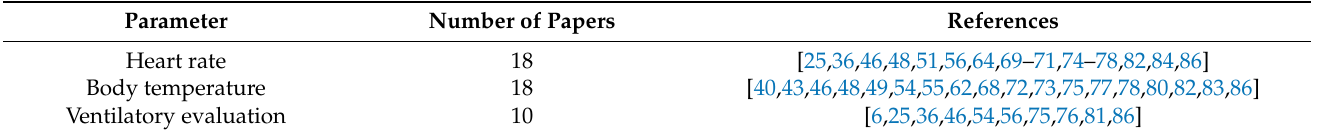
Table 2. Selected paper distribution based on the specific